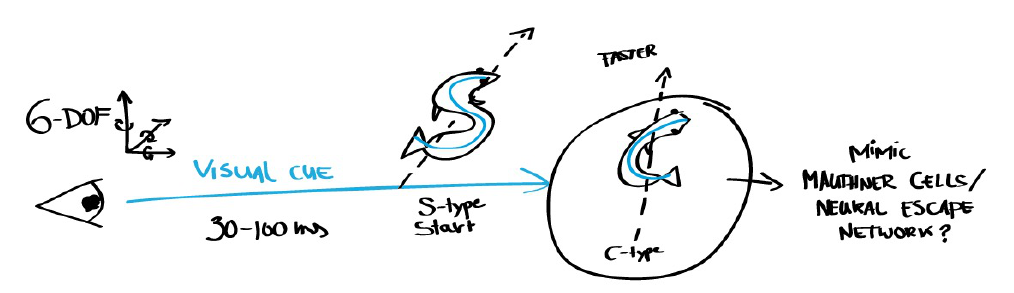
Figure 6. Example of simple sketches to capture abstracted relevant knowledge from